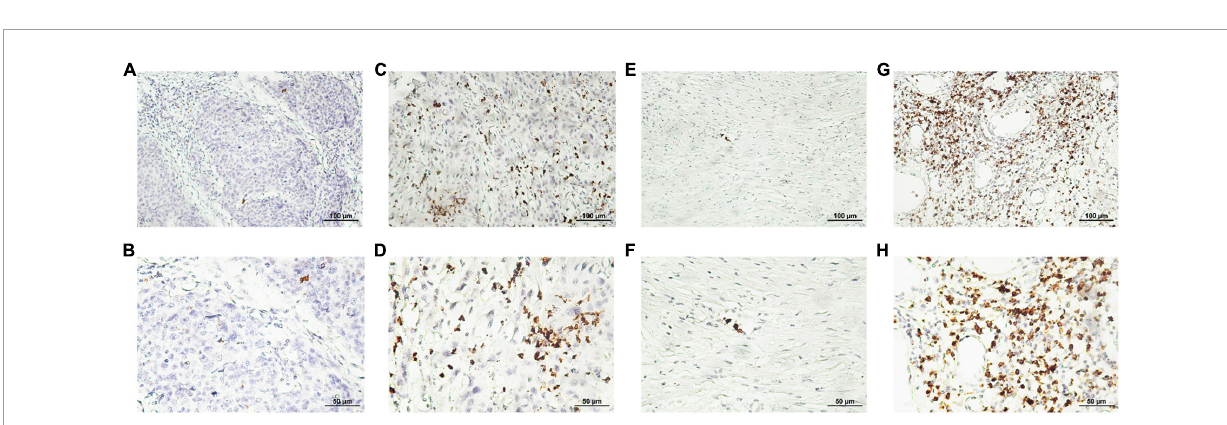
FIGURE4 Representative photomicrographs of immunohistochemical staining of CD15 + neutrophils. (A–D) Low and high intratumoral levels of CD15 + neutrophils, respectively. (E–H) Low and high peritumoral levels of CD15 + neutrophils, respectively (upper panels, × 200 magnification; lower panels, × 400